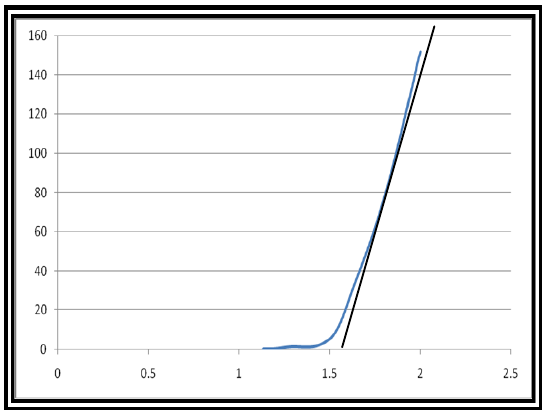
Fig. 11: (  hν) 2 as function of energy photon for different thickness of copper oxide thin film .